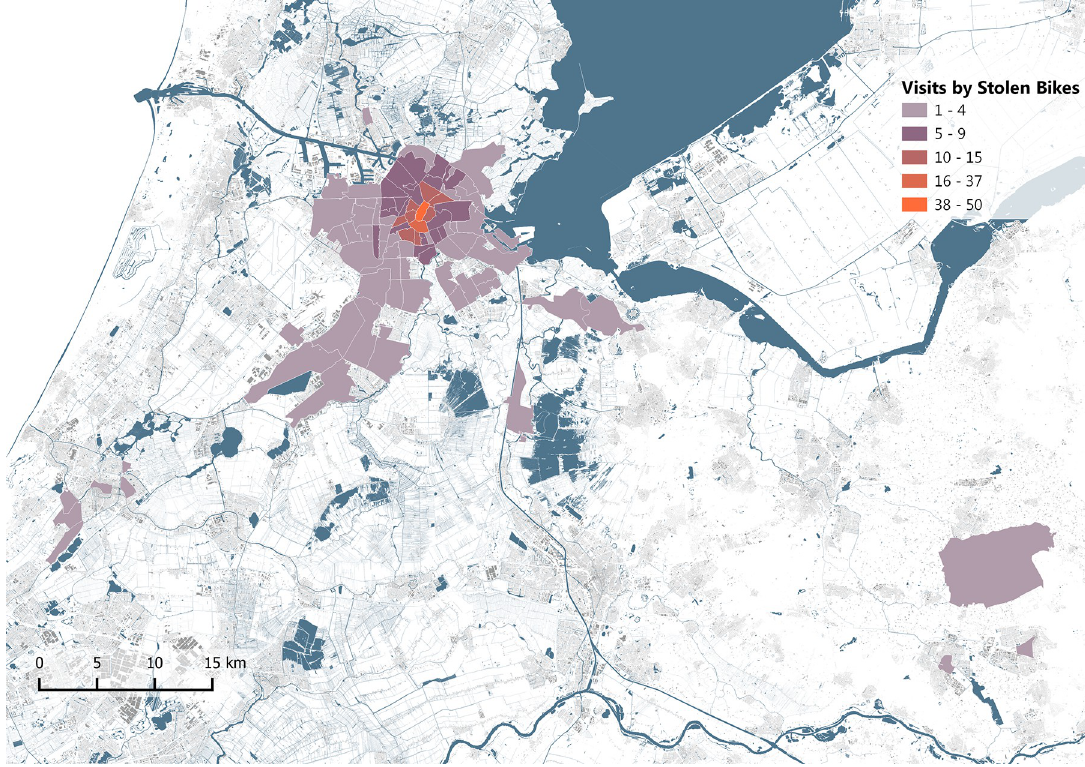
Fig 13. Visits of stolen bike to 4-digit postal code, base map data from OpenStreetMap.